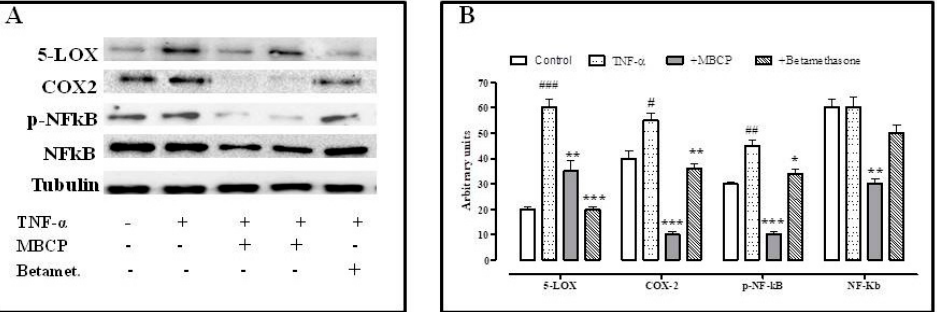
Figure 5. MBCP reduces the expression of 5-LOX, COX-2, p-NF- κ B and NF- κ B. ( A ) Western blot analysis of Caco-2 cells alone or treated with MBCP or betamethasone. Bands associated with the expression of 5-LOX, COX-2, p-NF- κ B, NF- κ B, and house-keeping γ -tubulin, after 48 h of treatment with MBCP (18 µ M) and betamethasone (10 µ M). The expression of the house-keeping protein γ -tubulin was used as loading control. ( B ) The expression levels of the above proteins are reported as a percentage with respect to the level of the protein in untreated cells, used as control. Bars show the mean ± SD of three different determinations. # p < 0.05, ## p < 0.01 and ### p < 0.001 vs. control; * p < 0.05, ** p < 0.01 and *** p < 0.001 vs. TNF- α alone.